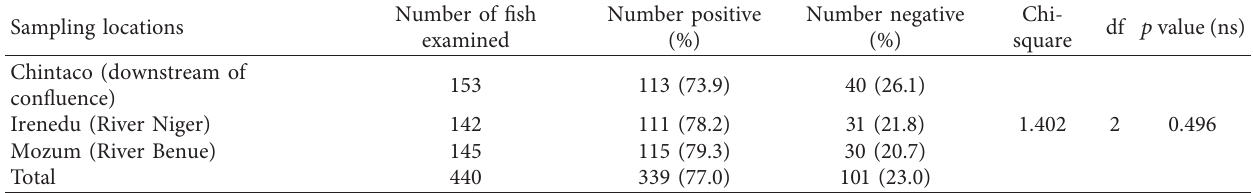
Table 6: Prevalence of fish parasites according to locations at rivers Niger and Benue,